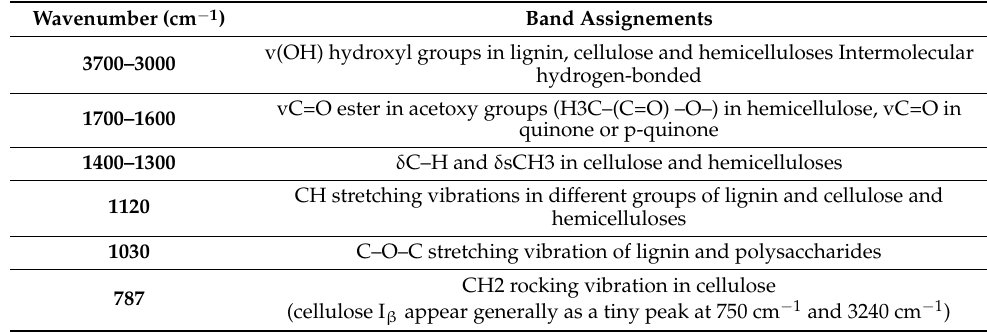
Table 4. Assignments of the main vibrations of the Infrared spectra.